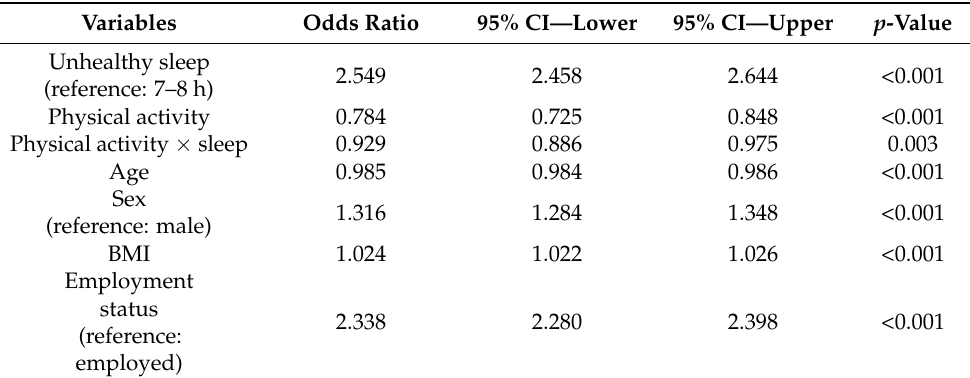
Table 5. The moderating effect of physical activity on the relationship between healthy sleep and emotional distress predictions among Blacks and Whites ( n = 274,041).